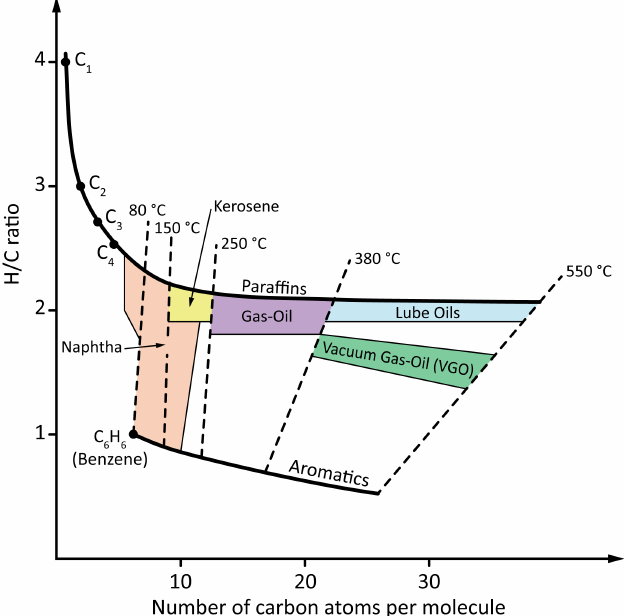
Figure 31. Hydrogen-to-carbon ratio for several petroleum cuts. Figure adapted from Ref.